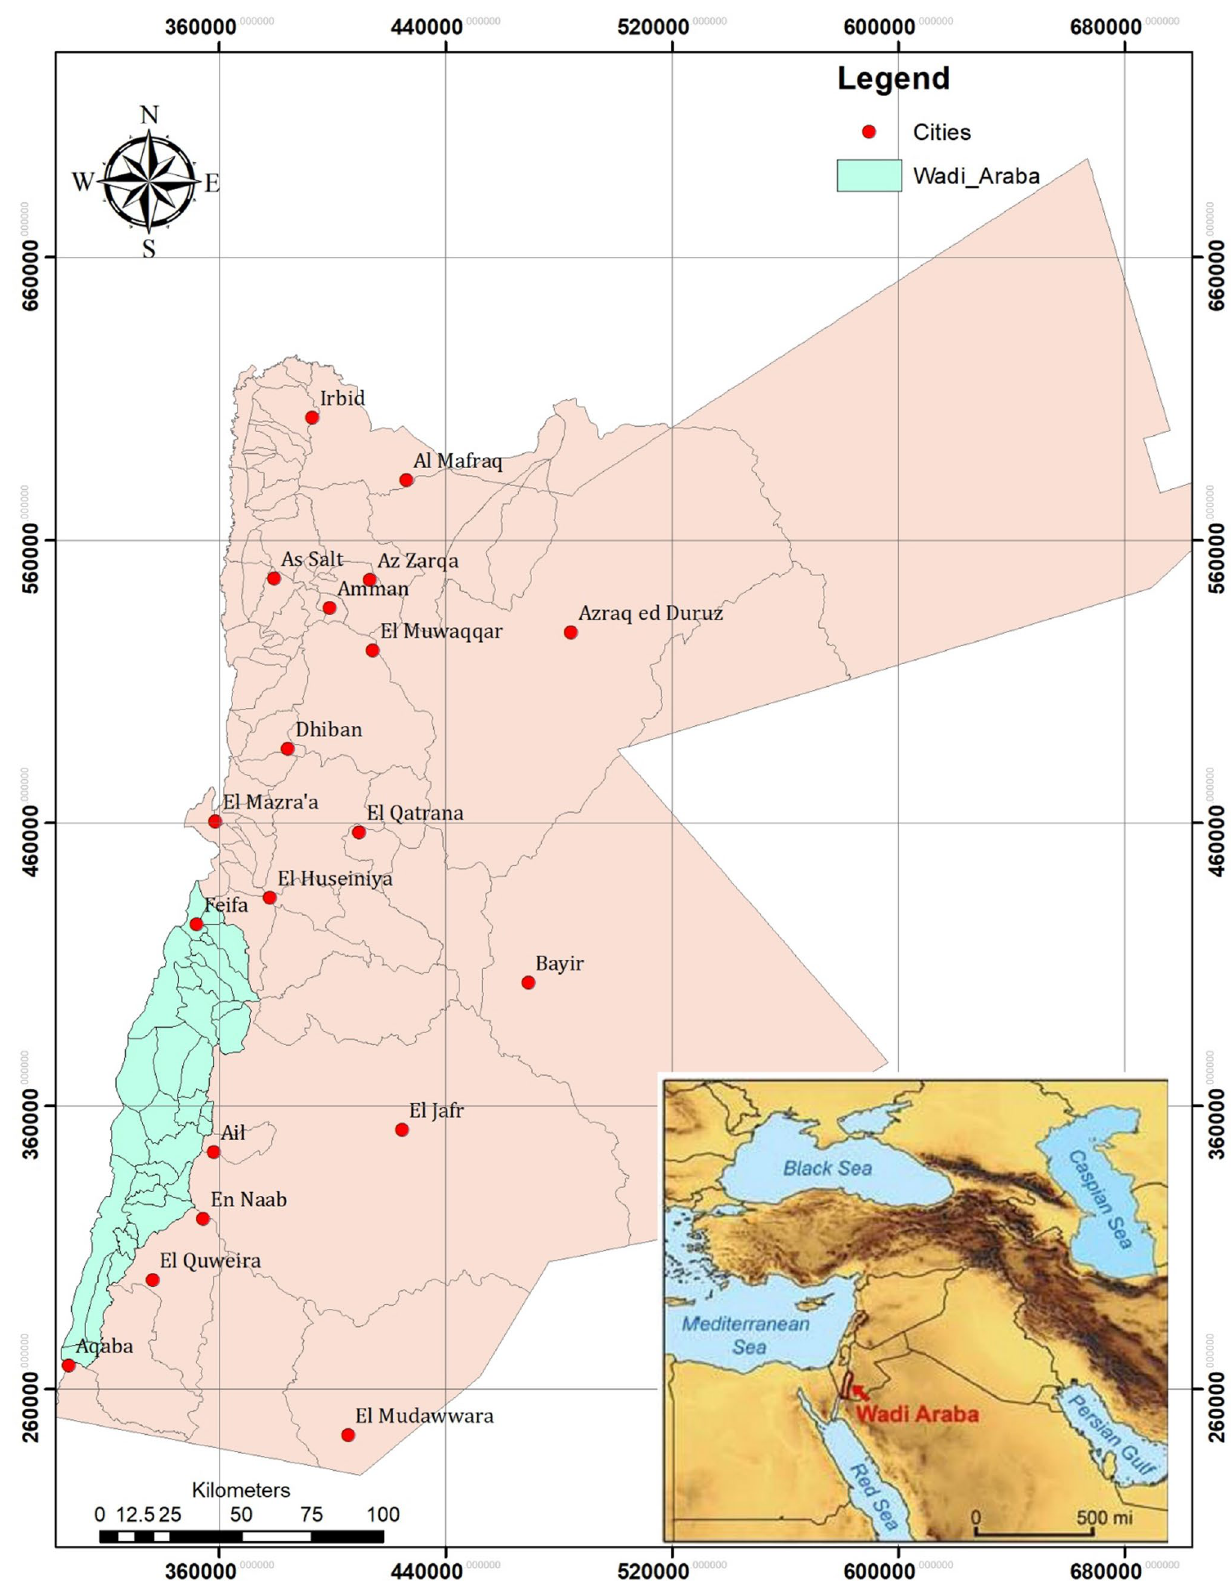
Fig. 1 Location map of Wadi Araba